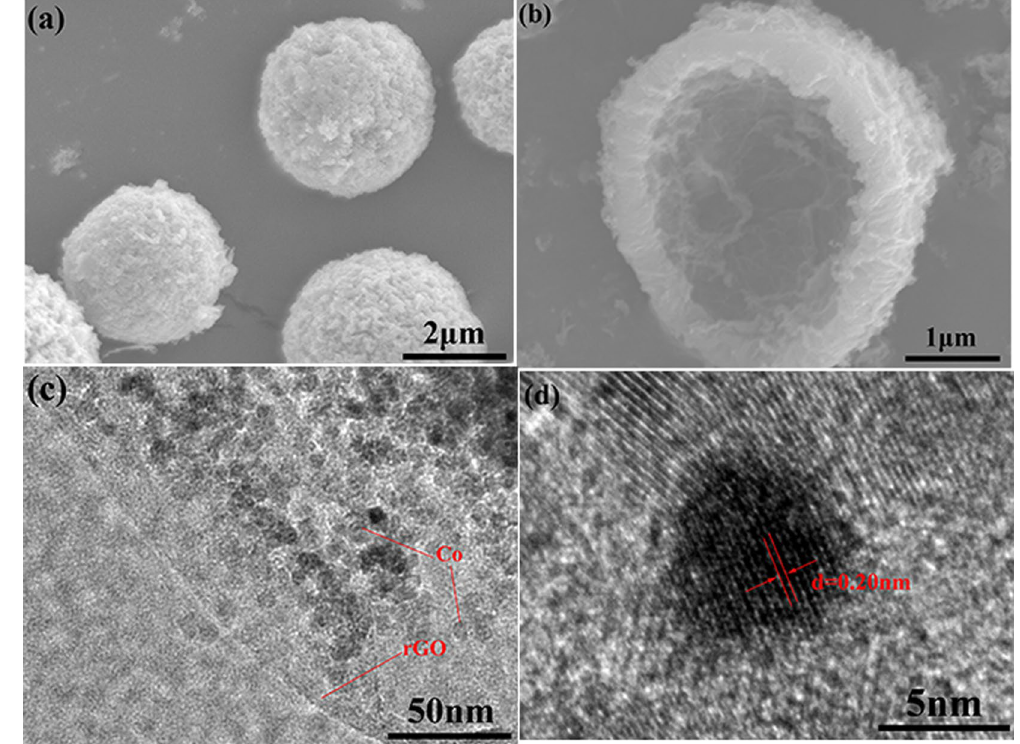
Figure 3. SEM images of ( a ) Air@rGO€Co microspheres (S 1.5 ), ( b ) cross-section of microsphere. ( c ) TEM image of a fragment from a microsphere which has been ultrasonic decomposed, ( d ) high magnification TEM image of the